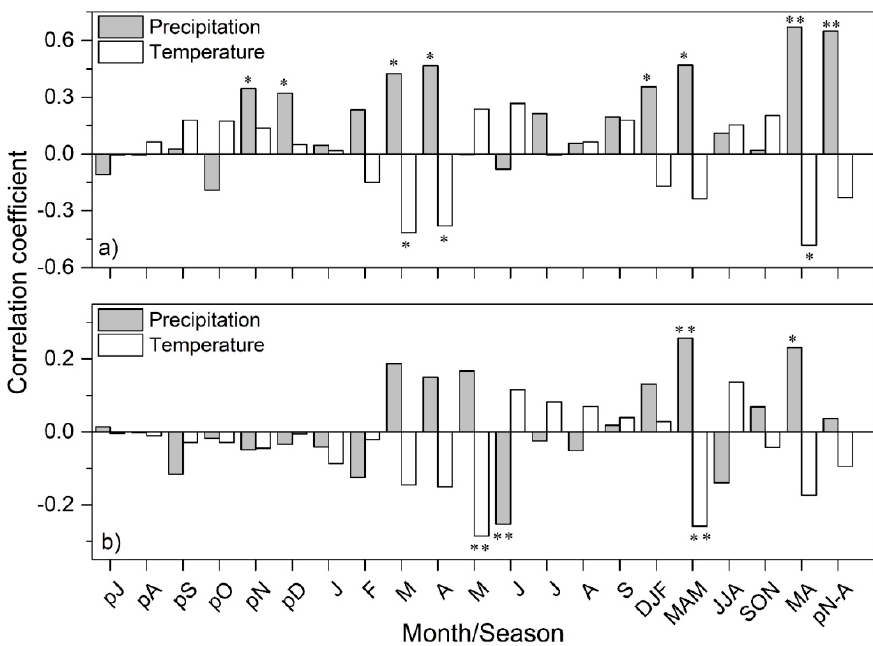
Figure 6. Pearson correlation coefficients calculated between ring-width indices and the mean of monthly, seasonal temperatures, and sum of monthly and seasonal precipitation from previous-year July (pJ) to current-year September (S), previous-year November to current year April (pN-A) based on climatic data from the meteorological records at Dadeldhura ( a ), Climate Research Unit (CRU) grid (29–29.5 ◦ N, 80.5–81 ◦ E) ( b ), and the Chir pine ring-width chronology from western Nepal. Significance levels: * p < 0.05 and ** p < 0.001. DJF: December to February; MAM: March to May; JJA: June to August; SON: September to November; MA: March to April.